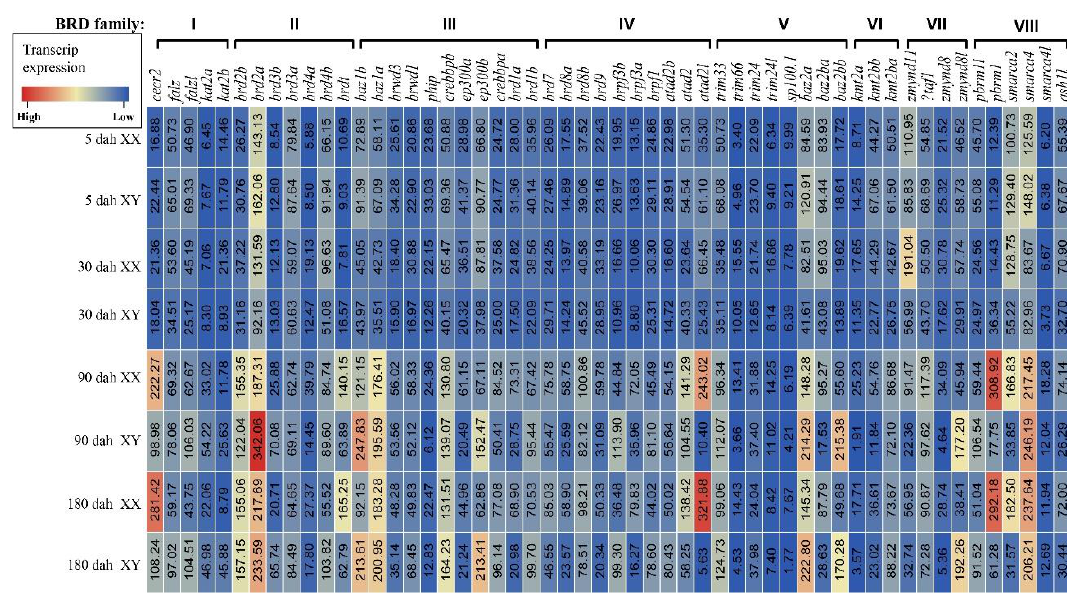
Figure 4. Transcriptomic data of BRDs at four developmental stages (5, 30, 90, and 180 dah) of Nile tilapia. A heatmap showing expression of BRDs in tilapia gonads at different developmental stages. Red shows high expression level and blue shows low expression level. dah, days after hatching.